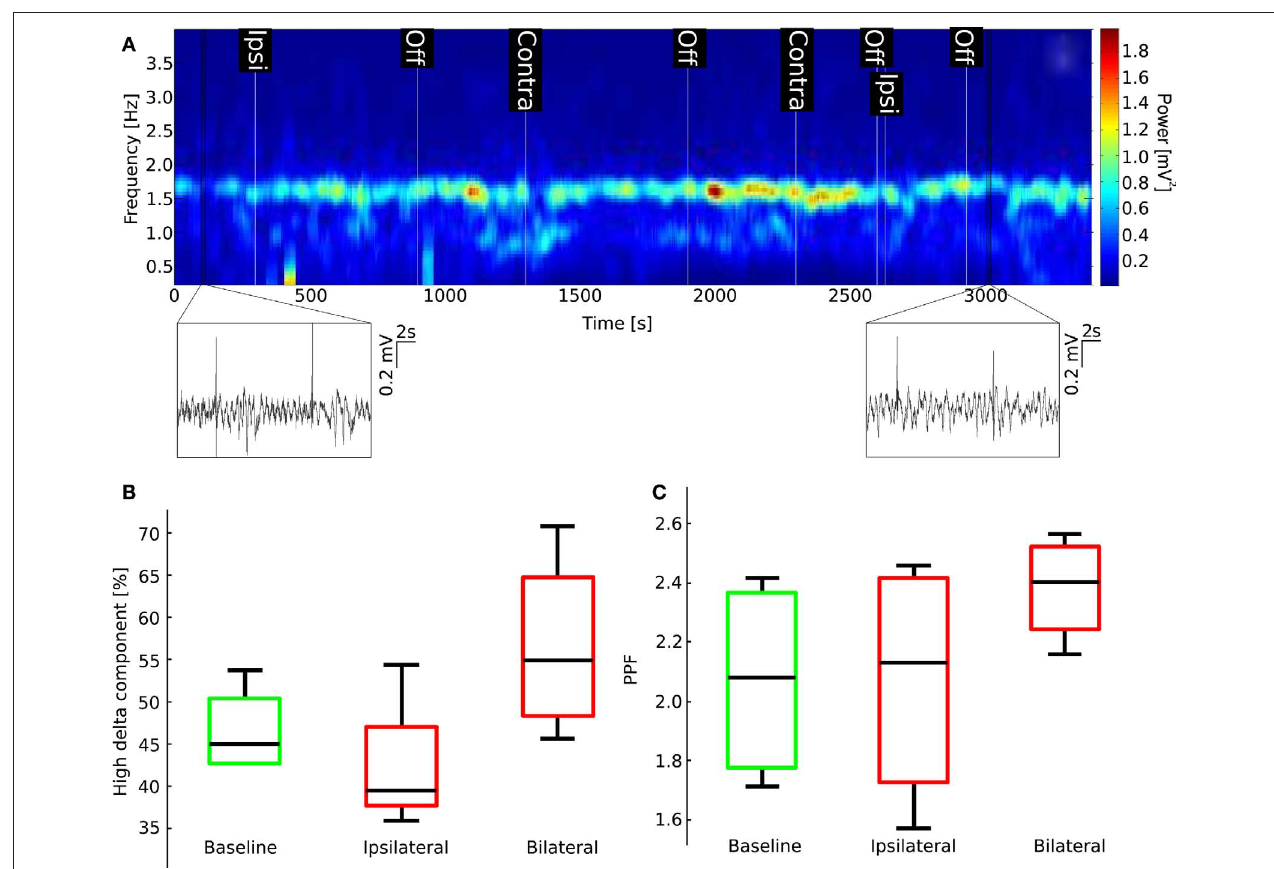
Figure 5 | Localized bilateral administration of MK-801 into the mPFCs does not have effects on LFP oscillations or PPF. (A) Spectrogram for a representative experiment does not show the characteristic appearance of a strong low‑delta component characteristic of systemic MK‑801 injection (cf. Figure 2 ; insets show two 20 s long LFP traces from the shown region of the